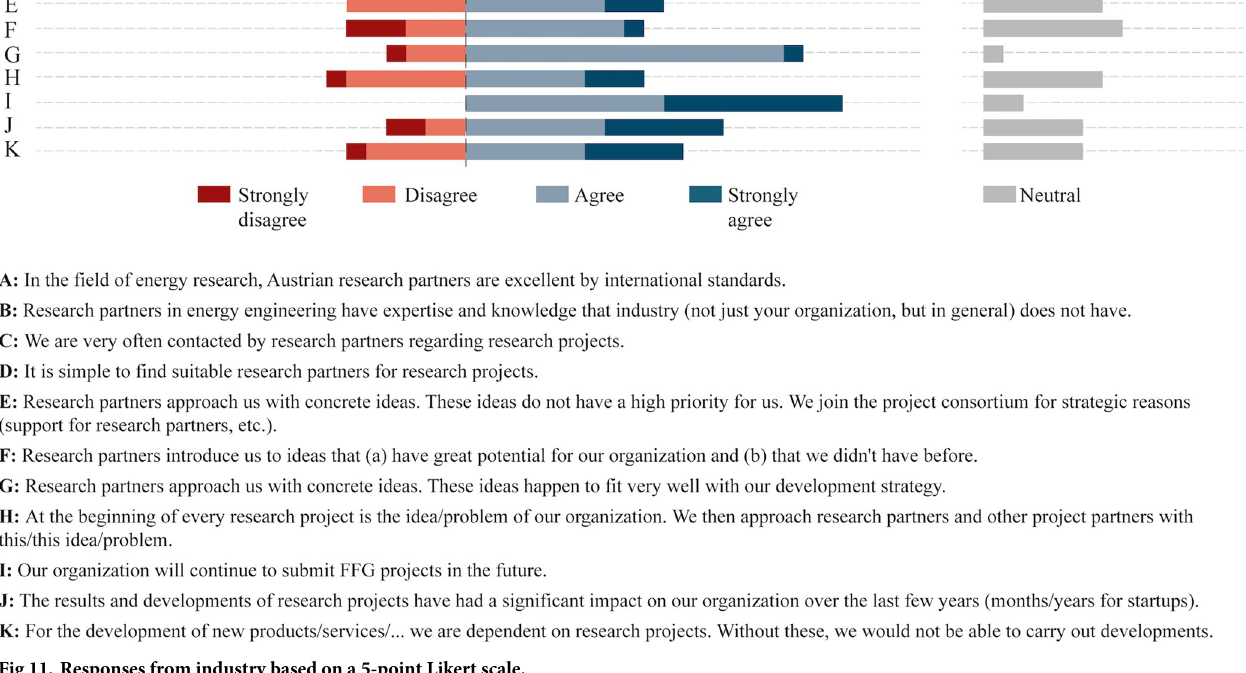
Fig 11. Responses from industry based on a 5-point Likert scale.